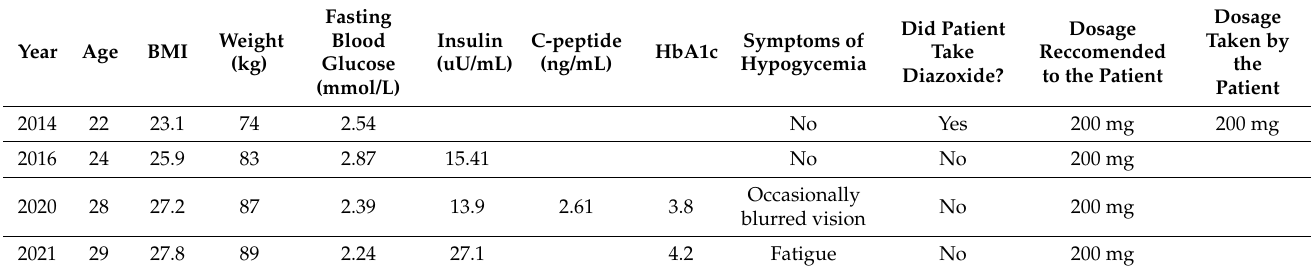
Table 4. Summary of metabolic profile results, concomitant symptoms of hypoglycemia and treatment in patient